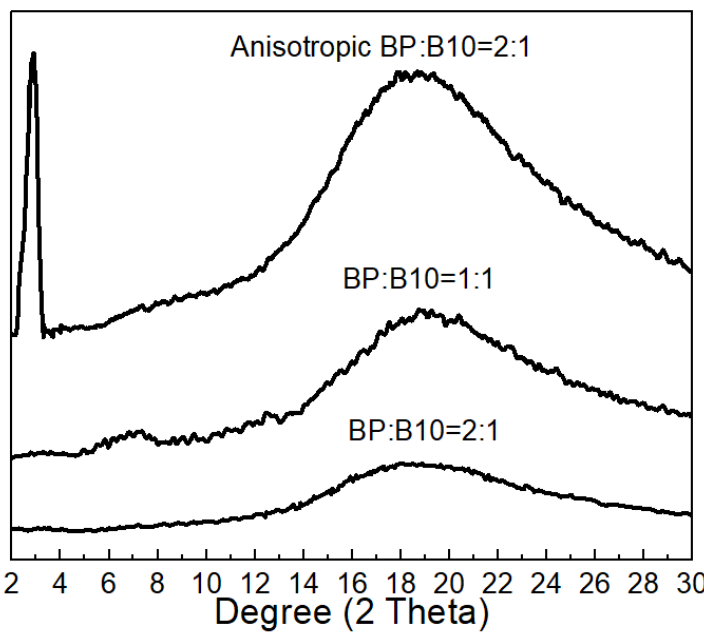
Figure 3. X-ray diffraction patterns of cured rigid-rod epoxy resins.